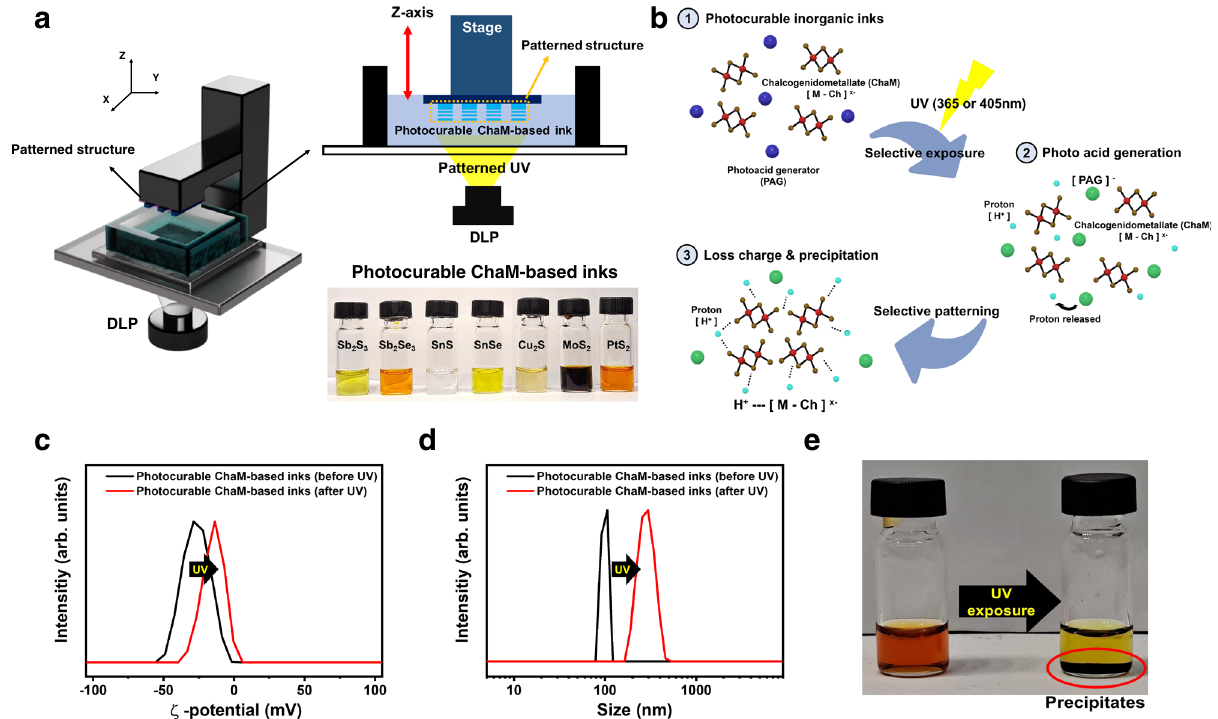
b Photocuring mechanism ofthe photocurableChaM-basedinks. The ChaMs react with the protons generated by the photoreaction of the photoacid generators (PAGs), causing precipitation of the ChaMs. c ξ -potential (zeta potential), d Dynamiclightscattering(DLS)size,and e photographofthephotocurableChaM- based inks before (black line) and after (red line) ultraviolet (UV)